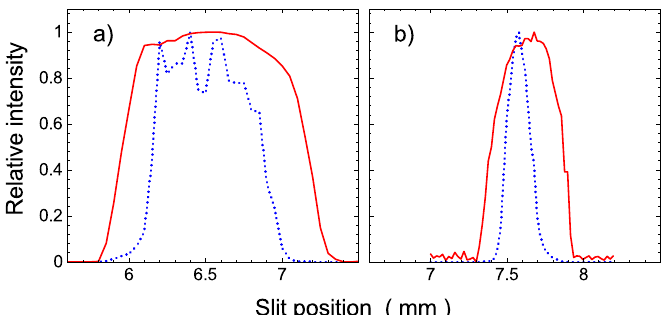
Figure 2. Measured horizontal ( a ) and vertical ( b ) beam profiles at the center of the interaction region [33] (reproduced by permission of the AAS). The red full and blue dashed curves represent the ion-beam (Ne + ) and photon-beam profiles,